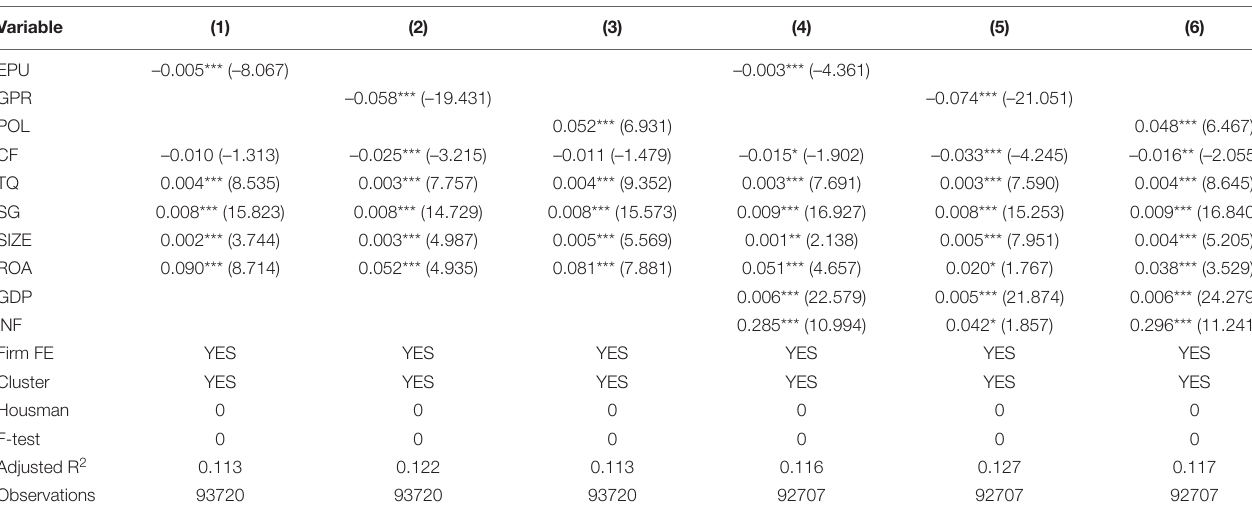
TABLE 5 | Assessed outcomes for equity financing.